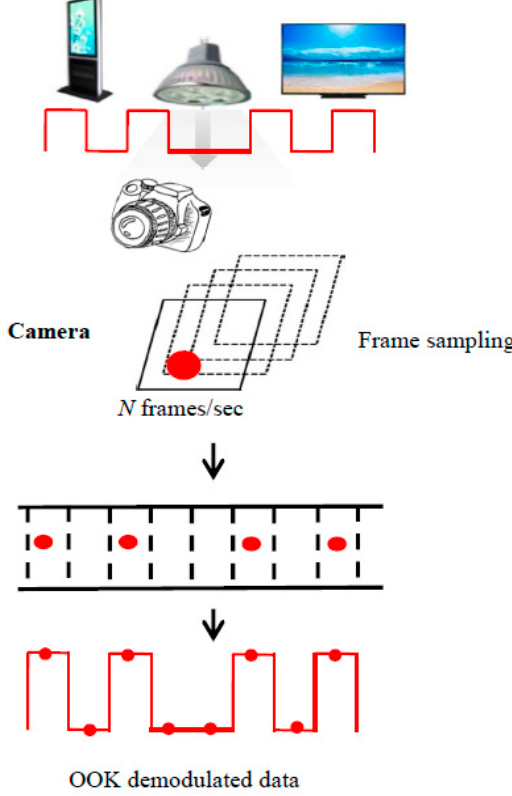
Figure 3. Three phases of fringe signal processing (Dibbiny and Kays, 2017).